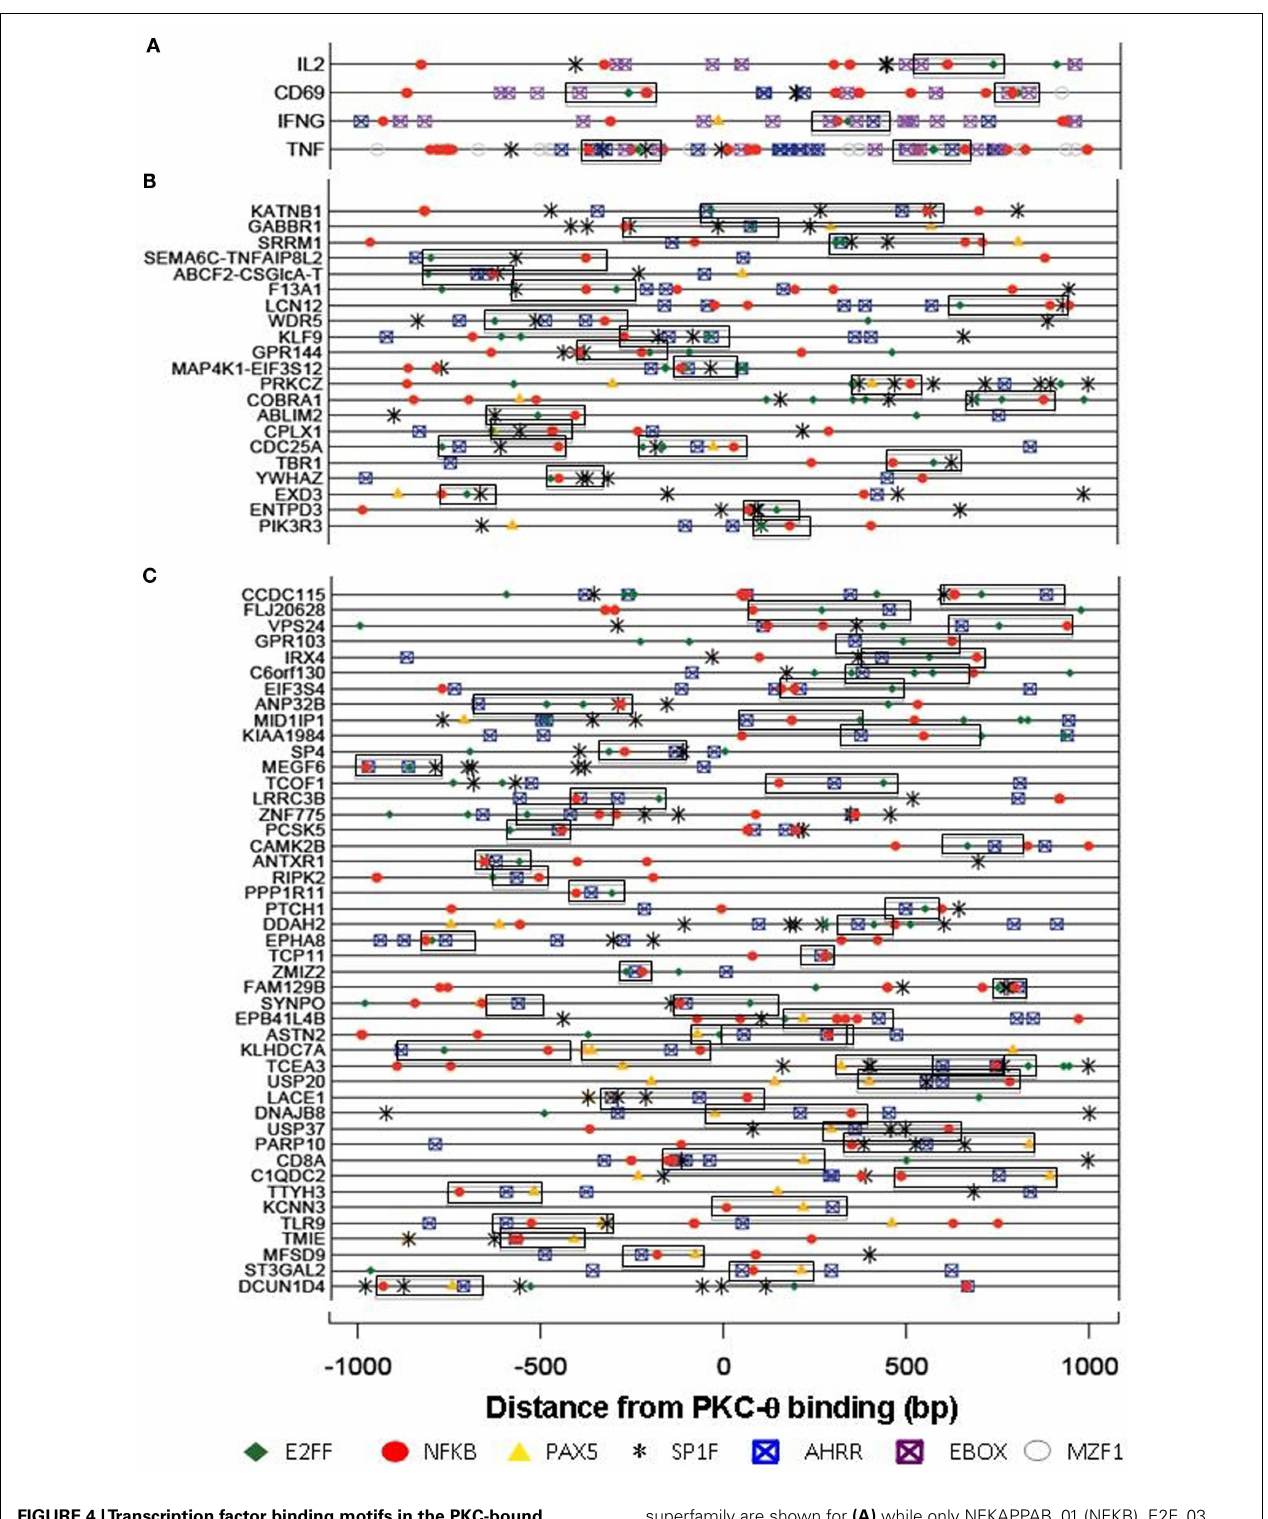
FIGURE 4 |Transcription factor binding motifs in the PKC-bound sequences. Motifs for members of the NFKB (red), E2FF (green), PAX5 (orange), AHRR (blue), EBOX (purple), MZF (gray), and SP1F (black) superfamilies were identified by their PositionWeight Matrices. PKC binds four inducible genes [ + 150bp downstream from the transcription start site (A) ], in promoter sequences (B) or within genes (C) . All motifs within a